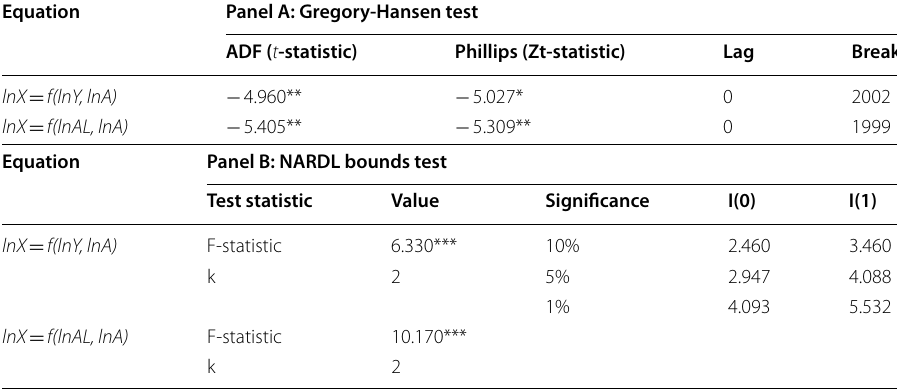
Table 2 Cointegration